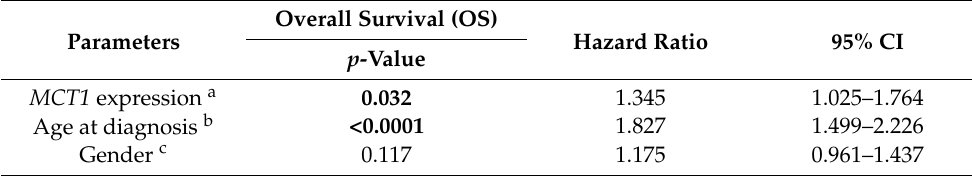
Table 1. Cox multivariable survival analysis in GBM patients from